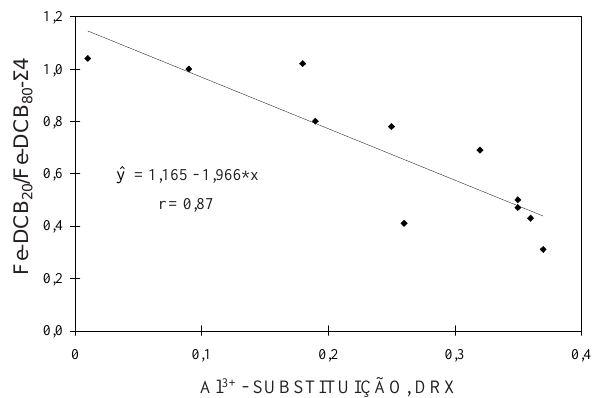
(DRX)Figura 2. Regressão entre a razão Fe-DCB DCB - ∑∑∑∑∑ 4 e a substituição de Fe 3+ por Al 3+ 80 em mol mol -1 determinada por difratometria de raios X nas amostras goethíticas. * Significativo a 1